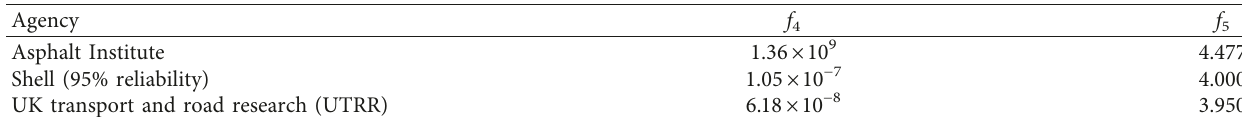
Figure 13: Fatigue cracking life of flexible pavement. (a) Asphalt Institute method. (b) Shell method. (c) TRRL Table 4: Coefficients for determining the rutting life.